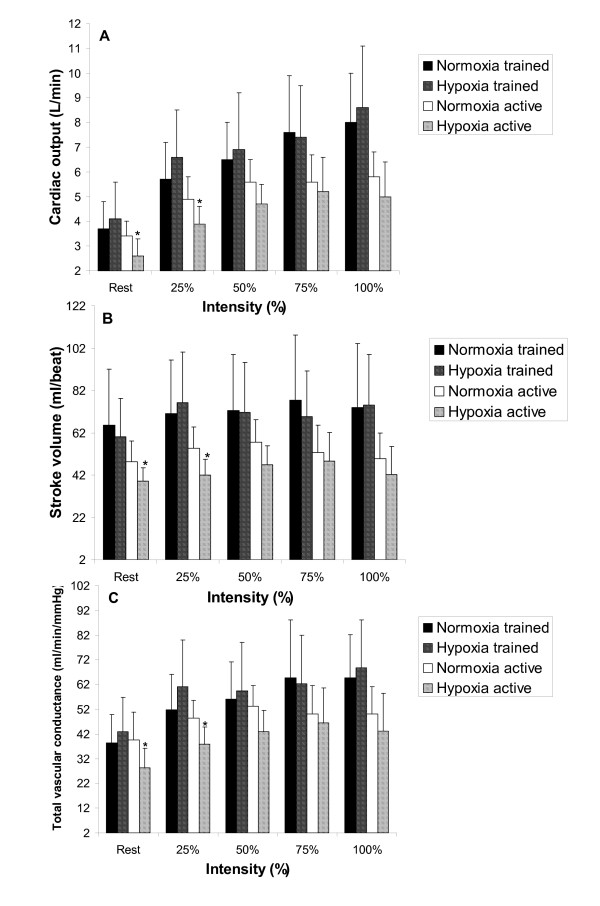
Comparison of cardiac output (Panel A), stroke volume (Panel B) and total vascular conductance (Panel C) for trained and active groups at each intensity of exercise. * means significantly different normoxia (p < 0.05).